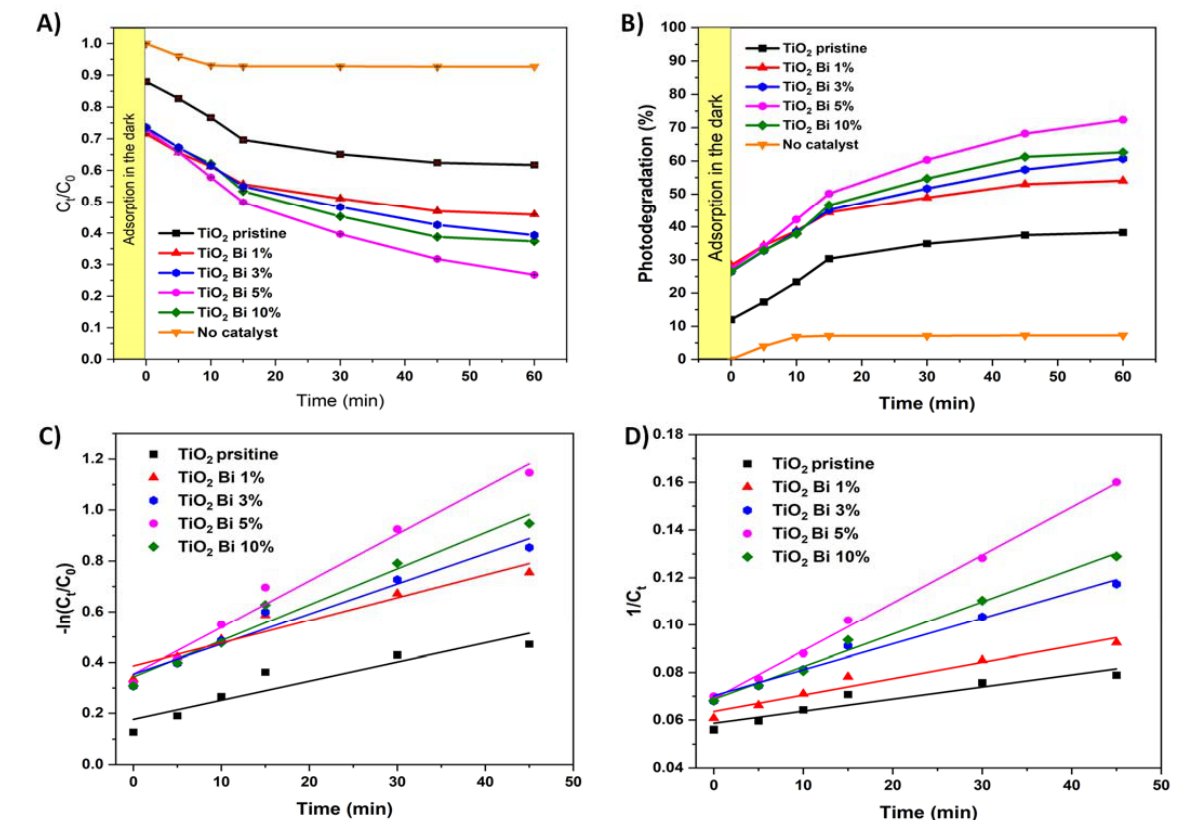
Figure 11. Photocatalytic activity ( A ) and photodegradation percentage ( B ) of MB under visible light